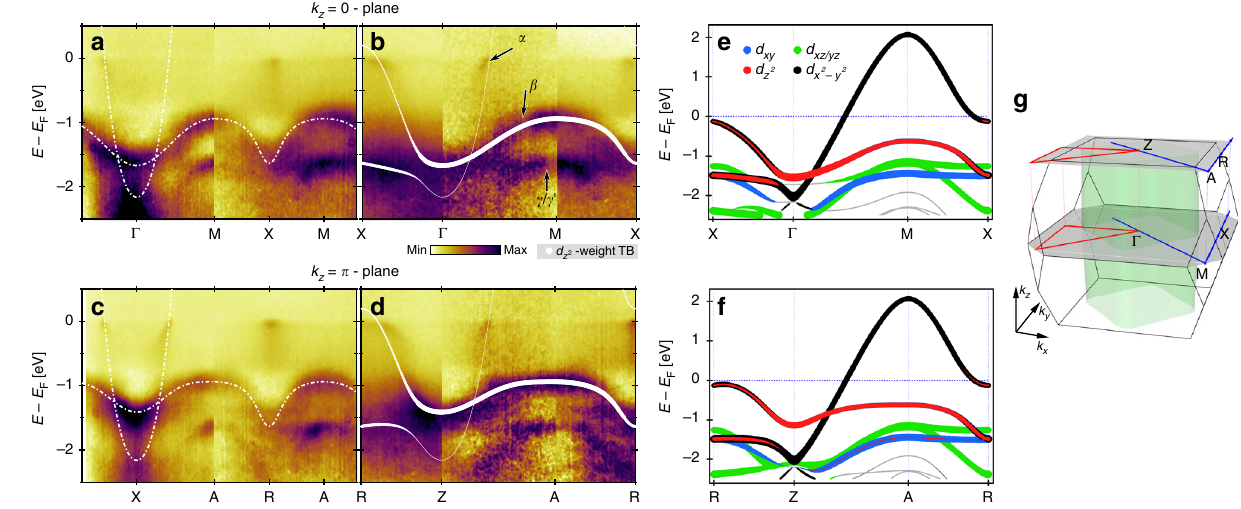
Fig. 2 Comparison of observed and calculated band structure. a – d Background subtracted (see Methods section) soft-X-ray ARPES EDMs recorded on La 2 − x Sr x CuO 4 , x = 0.23 along in-plane high-symmetry directions for k z = 0 and k z = π / c ′ as indicated in g . White lines represent the two-orbital ( d z 2 and d x 2 (cid:1) y 2 ) tight-binding model as described in the text. The line width in b , d indicates the orbital weight of the band structure at k z = 0 and k z = π / c ′ , calculated for La 2 CuO 4 (see Methods section). The colour code indicates the orbital character of the bands. Around the anti-nodal points (X or R), strong hybridisation of d z 2 and d x 2 (cid:1) y 2 orbitals is found. In contrast, symmetry prevents any hybridisation along the nodal lines ( Γ – M or Z – A). g Sketch of the 3D BZ of LSCO with high symmetry lines and points as indicated